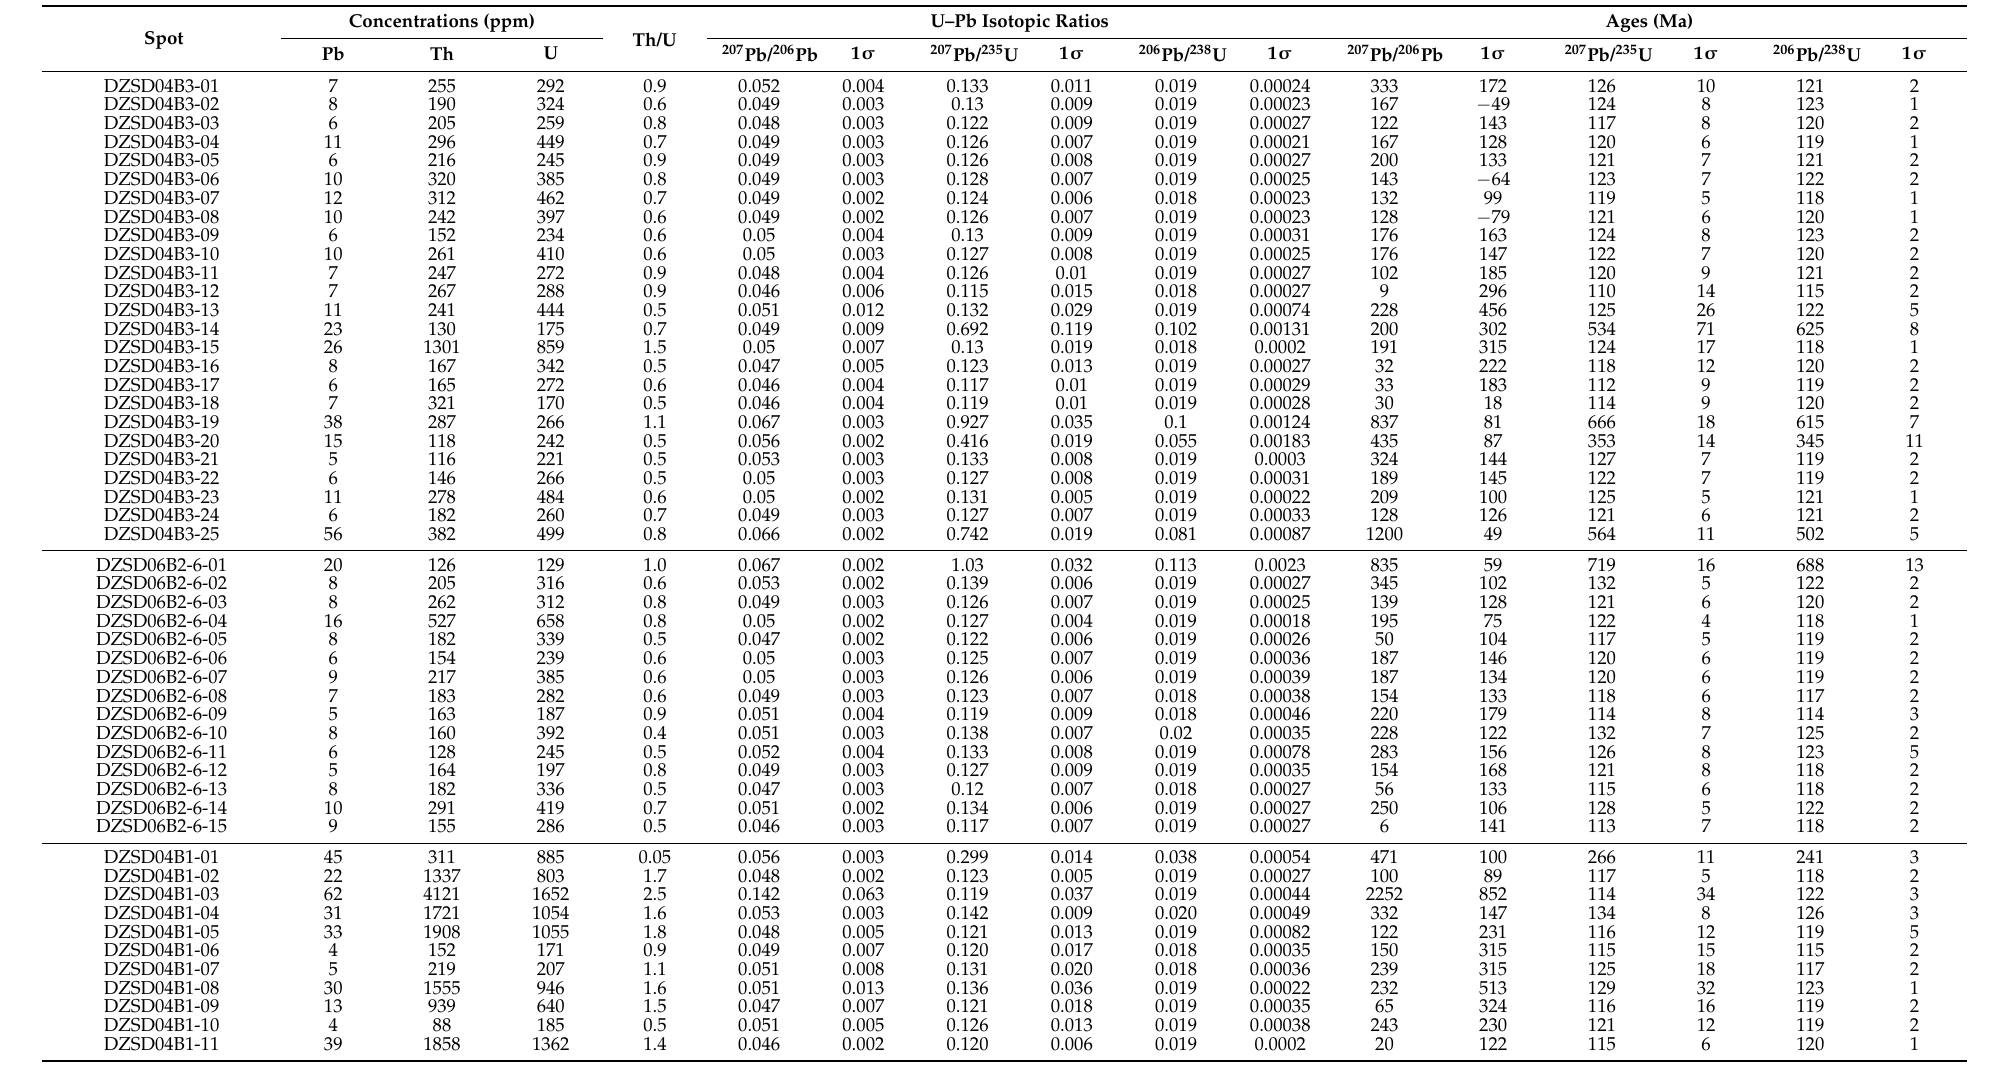
Table 1. LA-ICP-MS zircon U–Pb data of dark enclaves and host monzogranites of the Dazeshan